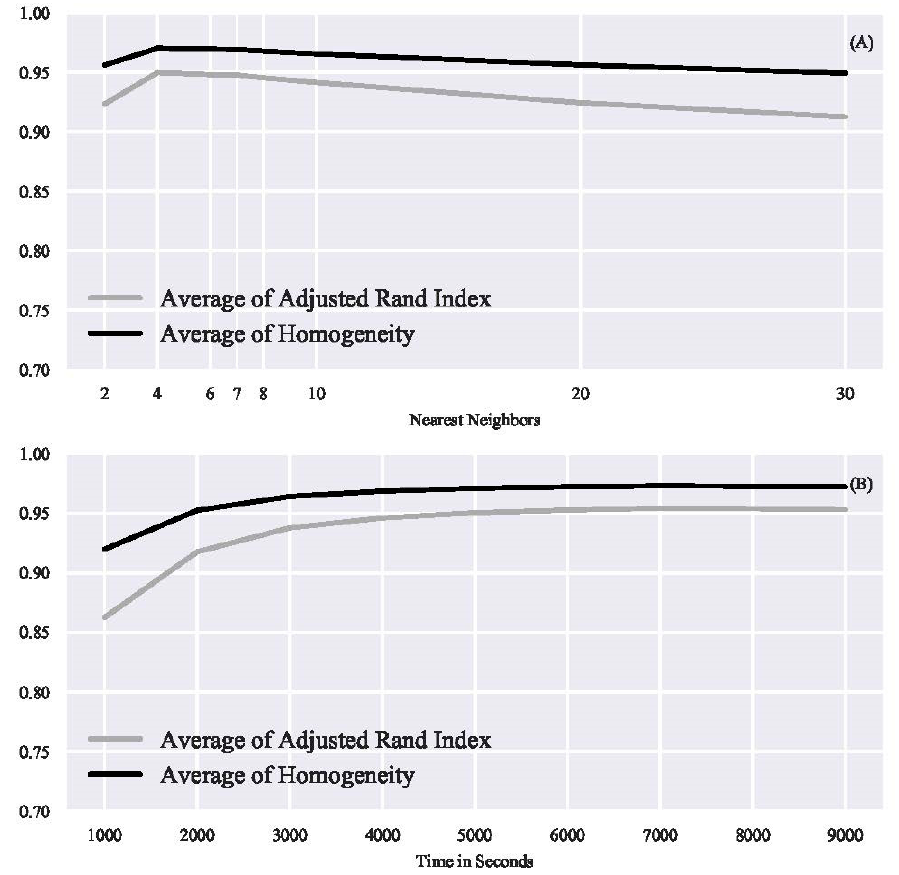
Figure 4. Average scores across di ff erent values for nearest neighbors across all the temporal scale values ( A ), and for di ff erent values of the temporal scale across all nearest neighbor scale values ( B ).